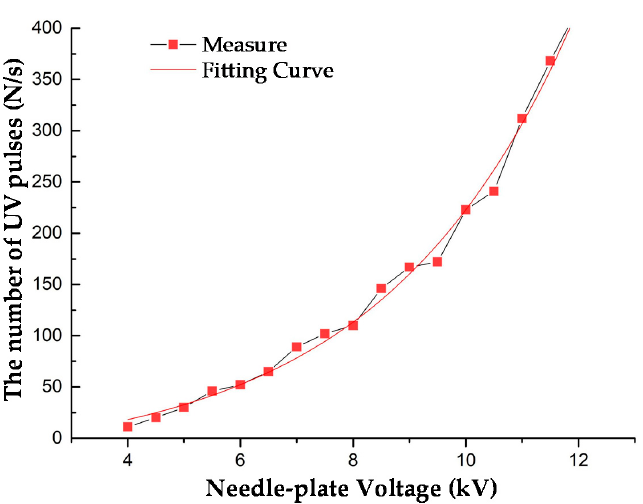
Figure 12. Relationship between needle-plate voltage and the number of UV pulses (D = 1 cm, L = 10 cm).